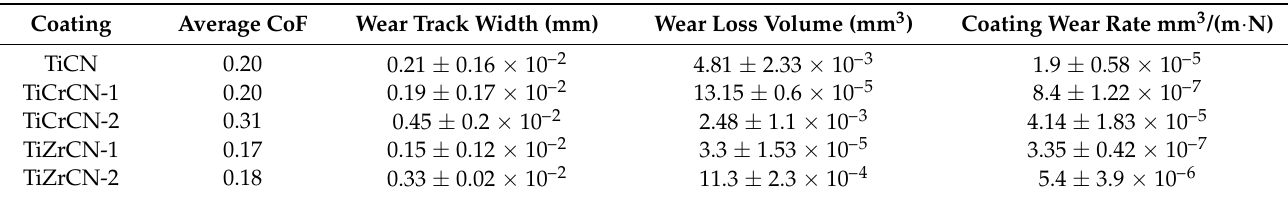
Table 5. The results of tribological investigations of TiCN, TiCrCN, and TiZrCN coatings. Coating